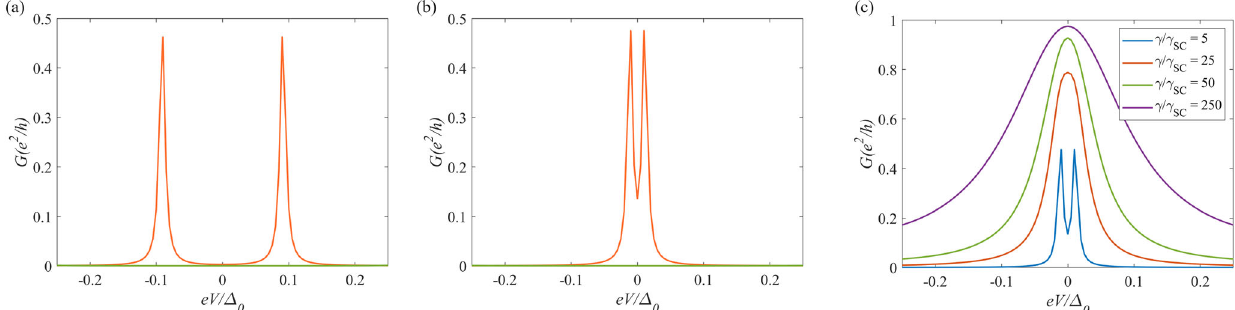
Fig. 3 Scaling of conductance quantization with bilayer coupling. a , b Low bias differential conductance plots for nanowires of length a 2.25 μ m, and b 4.5 μ m in the topological region (External Zeeman fi eld, V ext Z ¼ 0 : 07 Δ 0 ) (orange) and trivial region ( V ext Z ¼ 0 : 005 Δ 0 ) (green). The topological regime shows clear conductance peaks absent in the trivial regime, though not quantized. The splitting of the zero bias peak is more pronounced for the shorter nanowire, consistent with Fig. 2. c Shows that as the coupling to the normal contacts, γ , is increased, so that it becomes much larger than the coupling, γ SC , between the nanowire and the superconductor-magnetic insulator bilayer, the peak asymptotically reaches the expected quantized value. The bare superconducting gap in the parent superconductor Δ 0 sets the scale for all energies. The differential conductance, G is plotted as a function of the bias, V . G is measured in units of e 2 / h , which is the conductance quantum, e being the electronic charge and h being Planck ’ s